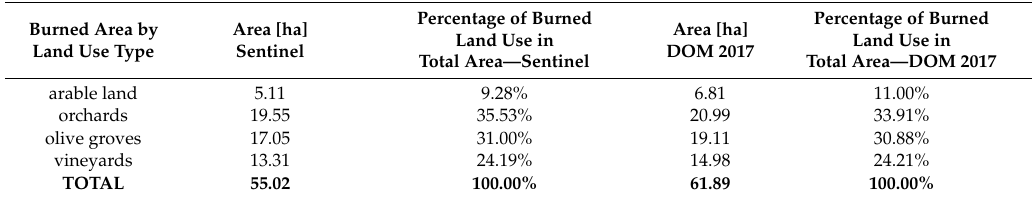
Table 1. Burned area by land use